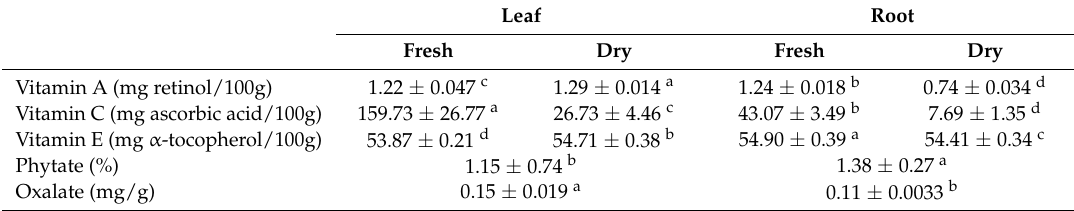
Table 2. Vitamin (A, C and E) and anti-nutrient (Phytate and Oxalate) composition of R.